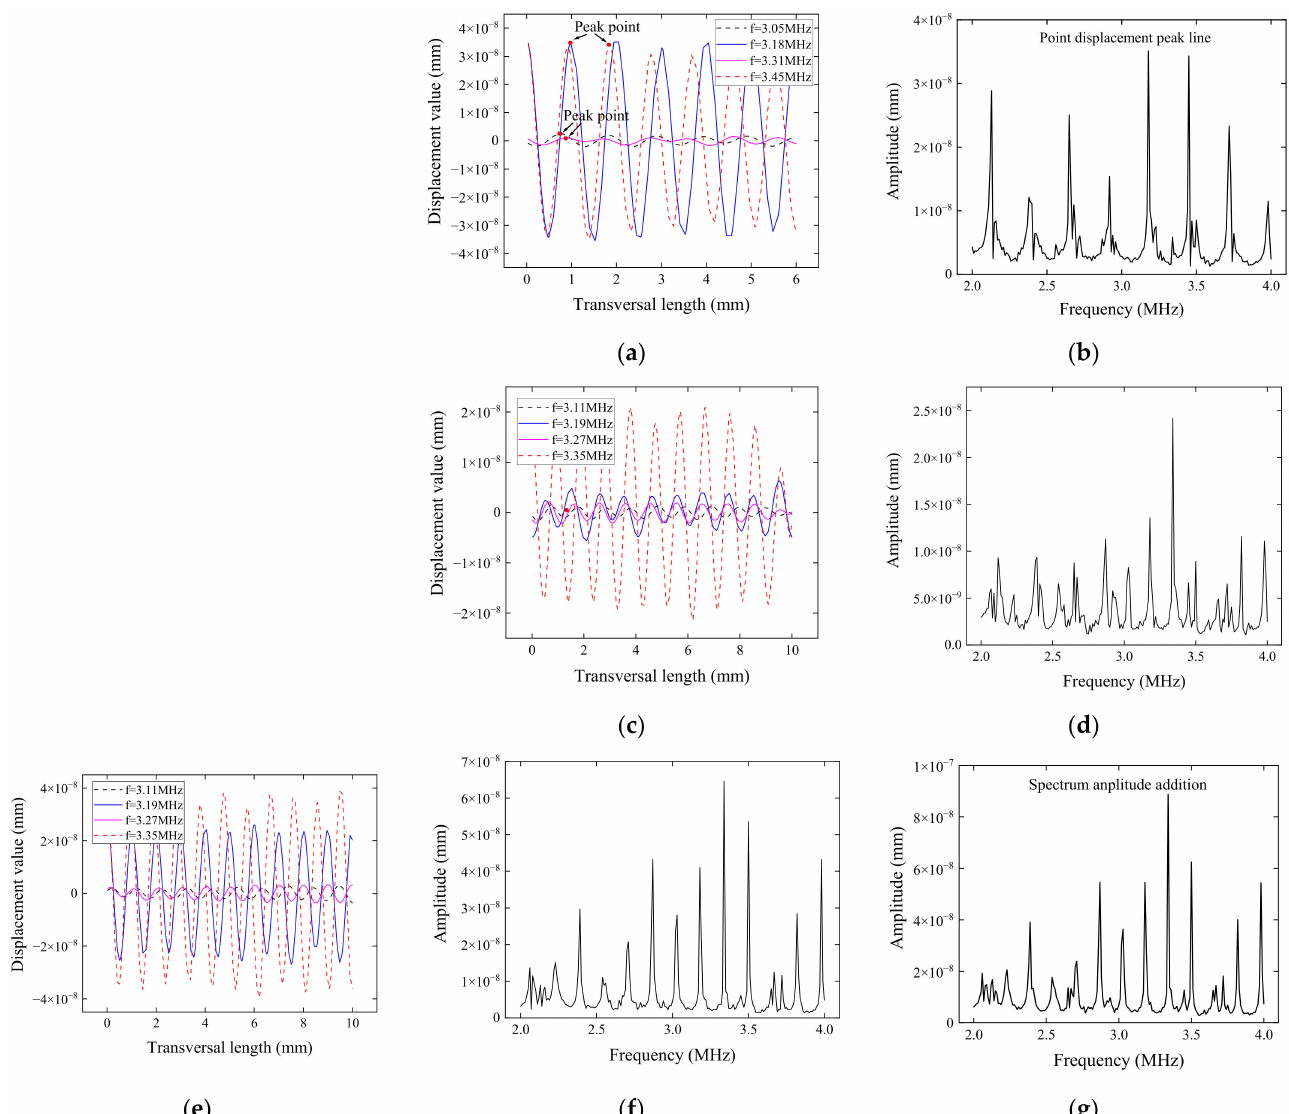
Figure 7. Schematic of the calculating procedure for the spectrum curve. ( a ) Displacement curve on transversal 1. ( b ) Transversal 1 spectrum diagram. ( c ) Displacement curve on transversal 2. ( d ) Transversal 2 spectrum diagram. ( e ) Displacement curve on transversal 3. ( f ) Transversal 3 spectrum diagram. ( g ) Figure 7d,f additive spectrum